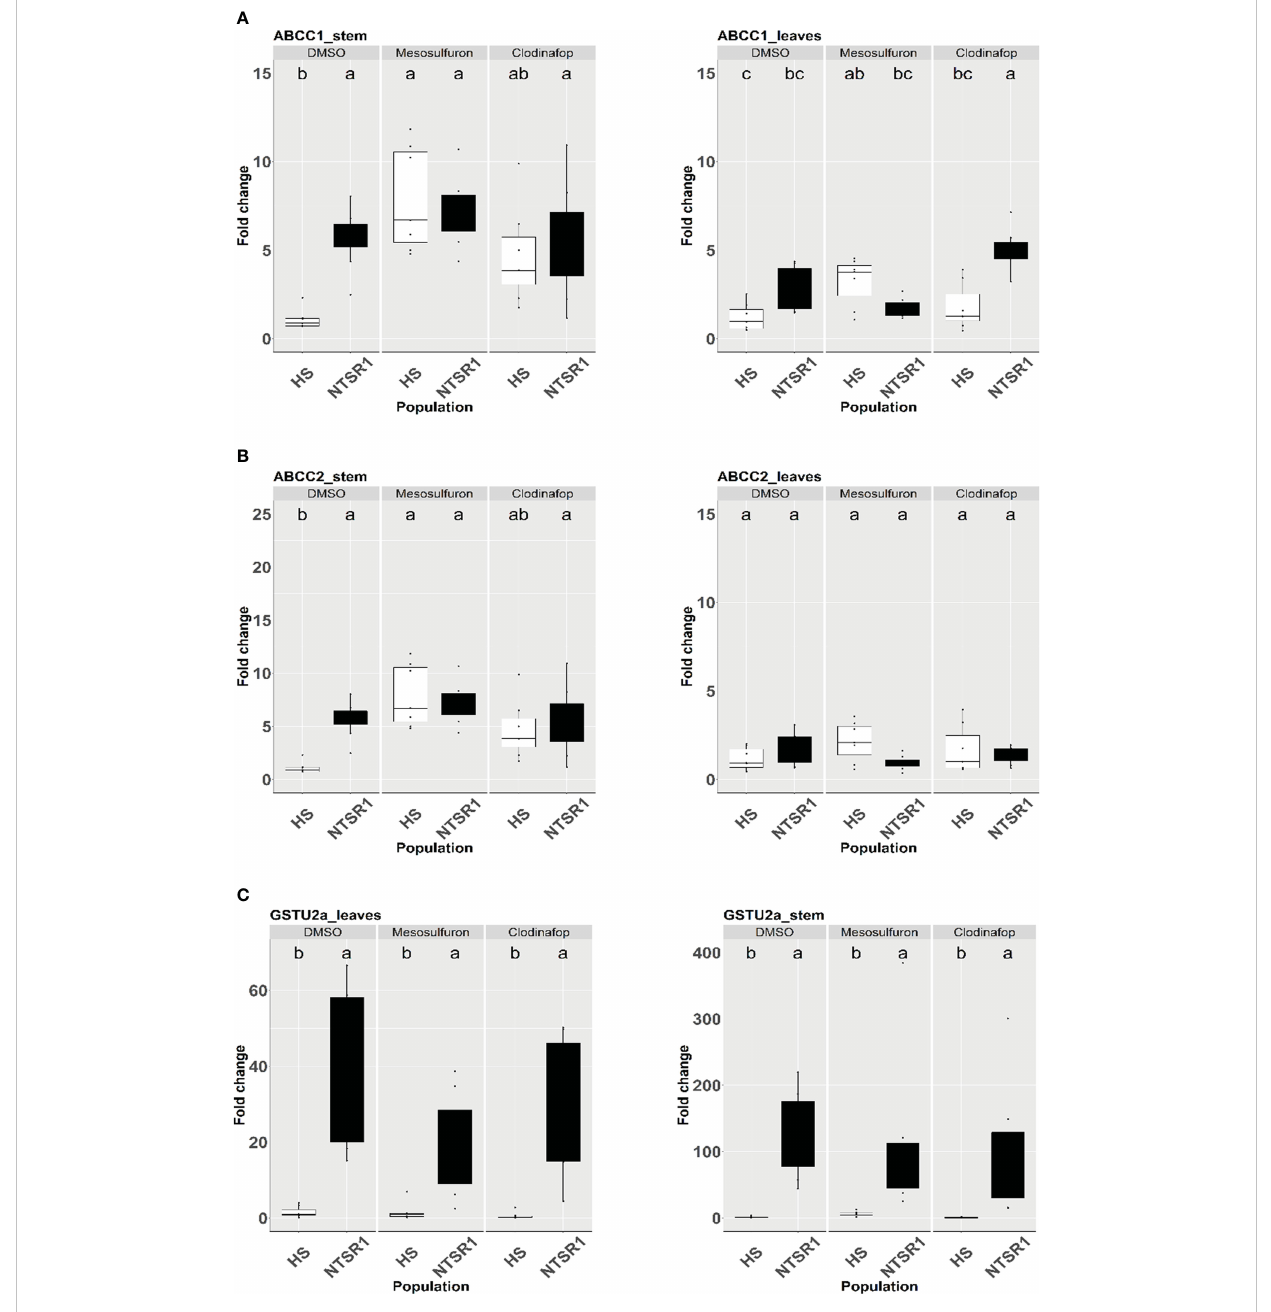
FIGURE 4 Effect of herbicide treatment on AmABCCs and A m GSTU2a transcript expression in HS and NTSR1 black-grass. The relative transcript expression of Am ABCC1 (A) , AmABCC-2 (B) , AmABCC3 (C) and AmGSTU2a (D) were determined in leaves and stems of HS and NTSR1 plants after a 24 h exposure to 40 µM mesosulfuron-methyl or 85 µM clodinafop-propargyl. Box plots represent relative expression (n=7) of transcripts in each biotype as relative fold ‐ expression of genes compared with solvent control treatments. Different letters designate statistical difference of transcript expression within each